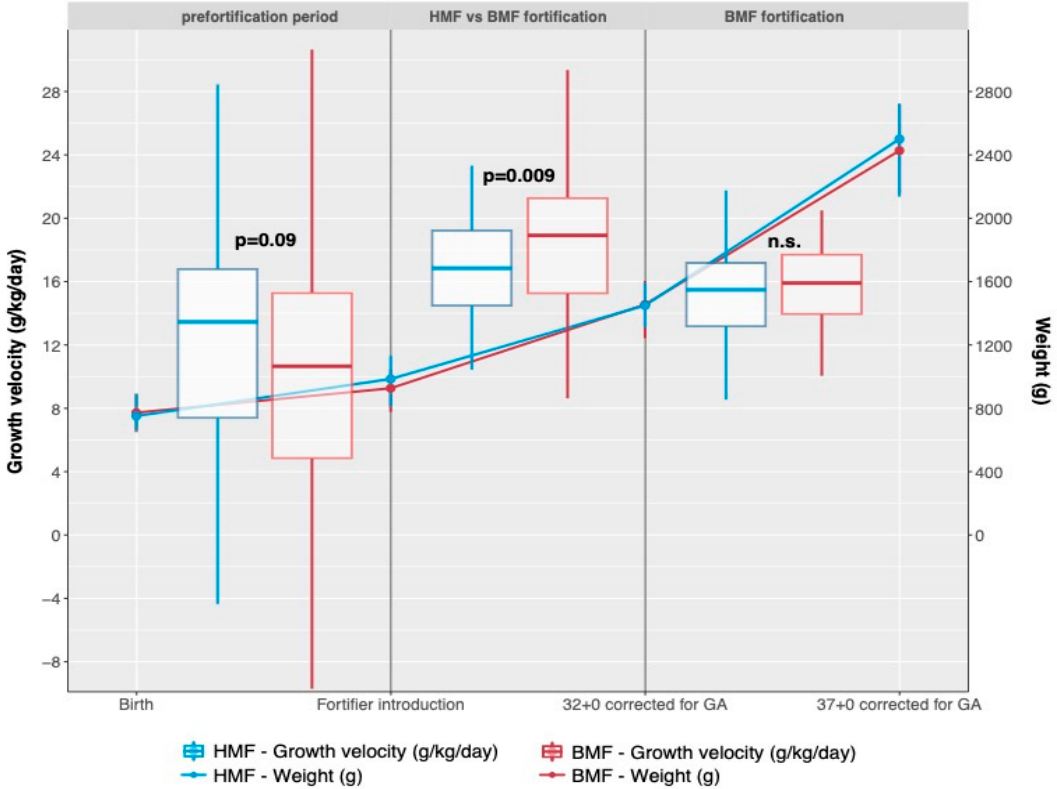
Figure 2. Comparison of absolute weight and growth velocities between